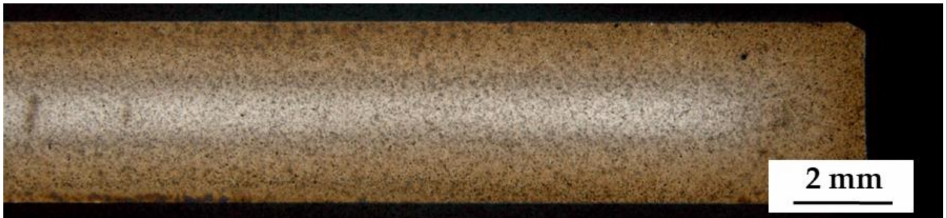
Figure 6. Macroscopic overview of the polished section of the carburized sample with hollow spheres.